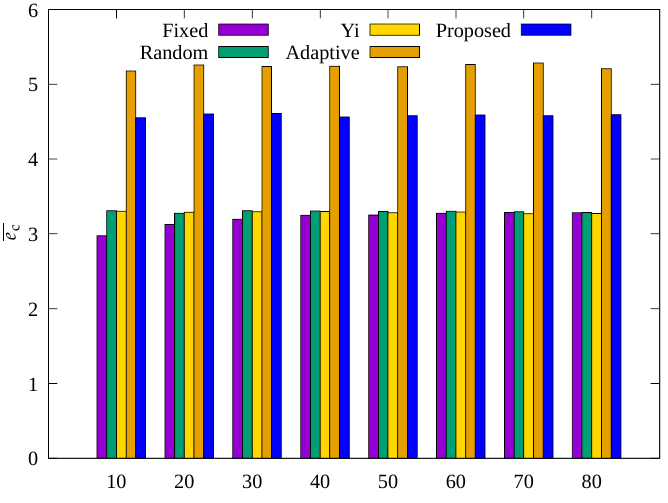
Figure 9. Comparison of the average amount of consumed energy according to number of MDTs.